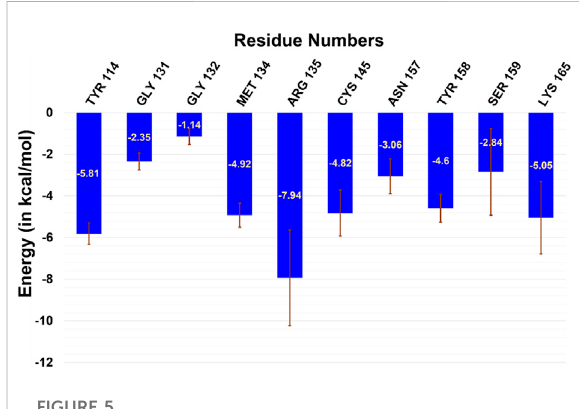
FIGURE 5 Residue-wise decomposition of the total binding free energy of